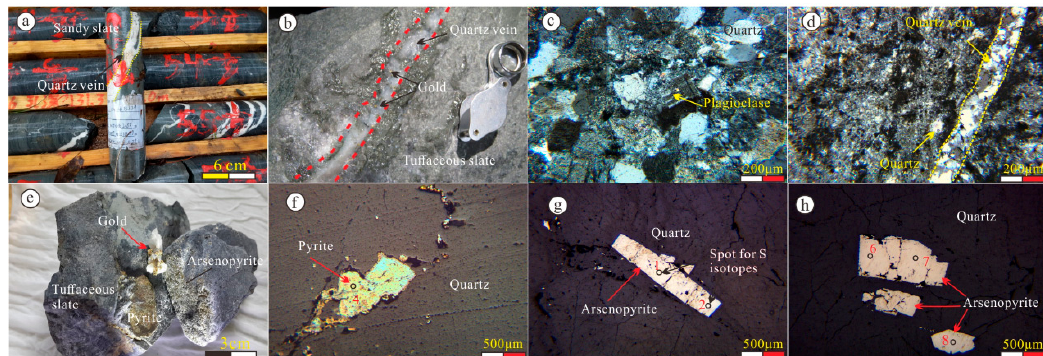
Figure 4. Morphology and mineral assemblages of the surrounding rocks, ore body and gold-bearing ore. ( a ) Quartz vein in the sandy-slate; ( b ) Gold-bearing Quartz vein in the tu ff aceous slate; ( c ) Quartz and plagioclase in the sandy-slate; ( d ) Quartz veinlet in the tu ff aceous slate; ( e ) Quartz, native gold, pyrite and arsenopyrite in the tu ff aceous slate; ( f ) Pyrite in the quartz vein showing the location of the in situ sulfur isotopic analyses; ( g ) Clintheriform arsenopyrite in the quartz vein showing the spots of the in situ sulfur isotopic analyses; and, ( h ) Euhedral arsenopyrite in the quartz vein showing the spots of the in situ sulfur isotopic analyses.